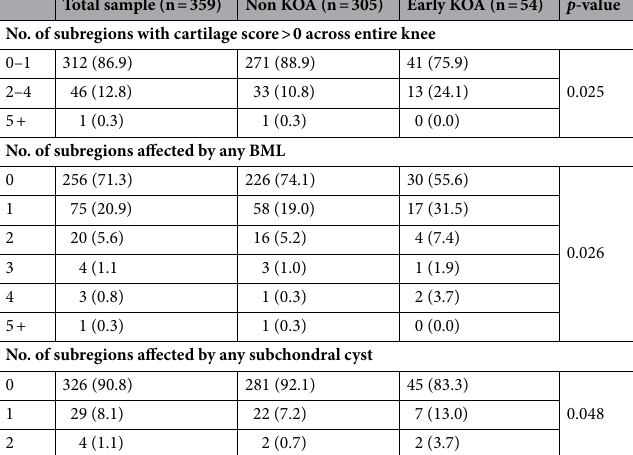
Total sample (n = 359) Non KOA (n = 305) Early KOA (n = 54) p -value No. of subregions with cartilage score > 0 across entire